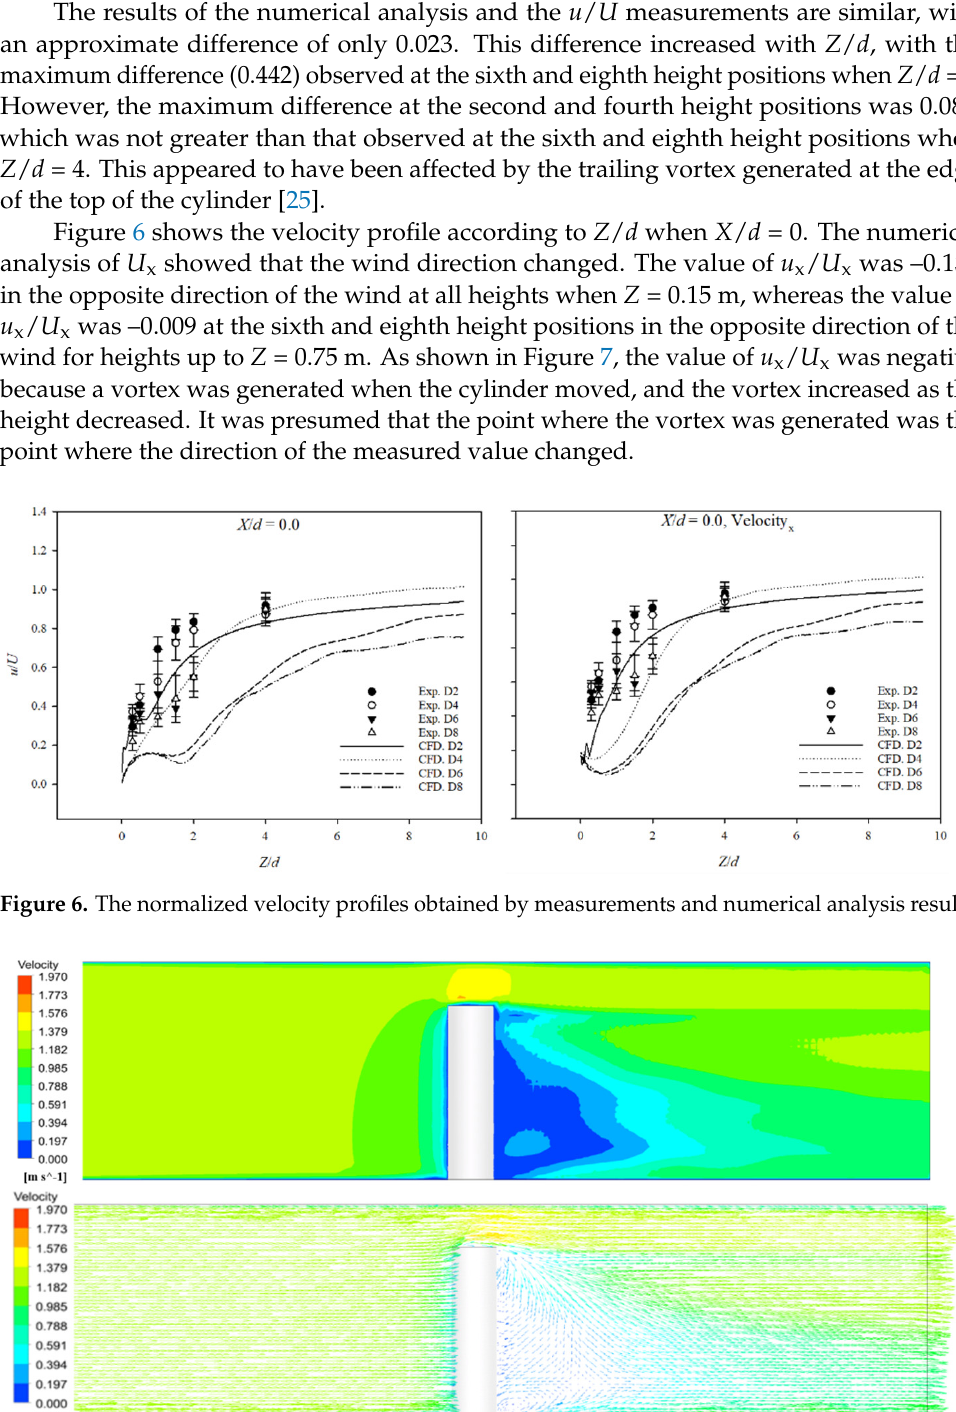
Figure 8. Time-averaged streamlines in different x–z planes.